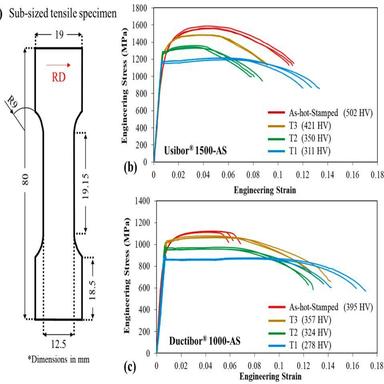
Sub-sized Tensile test specimen and engineering stress-strain curves for as-hot-stamped Usibor® 1500-AS and Ductibor® 1000-AS adapted from Samadian et al. and Lee and the tempered HAZ materials tested as part of the current work.